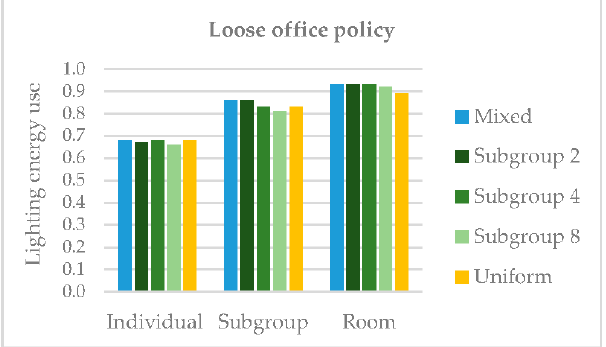
Figure 10. Lighting energy use of the three control strategies for the five function distributions with a loose office policy.